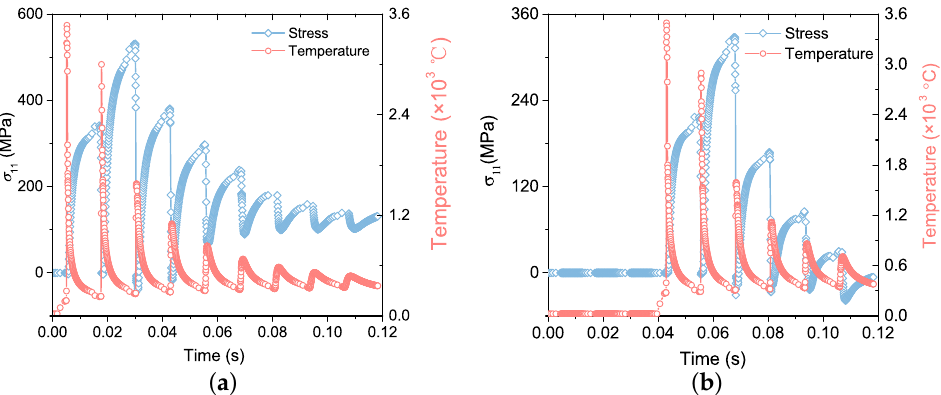
Figure 10. Stress and temperature distribution path along x -direction at the end time of each layer. ( a ) Stress and temperature distribution path along x -direction of the 1st layer. ( b ) Stress and tempera- ture distribution path along x -direction of the 4th